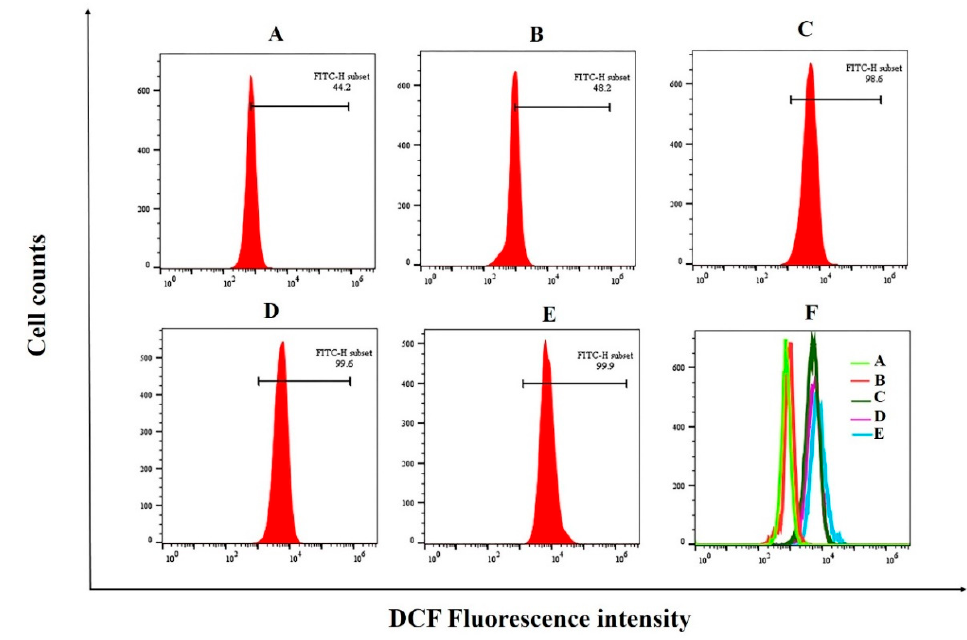
Figure 9. Effect of PED treatment on ROS generation in HepG2 cells. ( A ): untreated cells; ( B – D ): 250, 500, and 1000 µ g/mL; ( E ): 5-FU; ( F ): ROS generation profiles under treatment with different concentrations of PED.